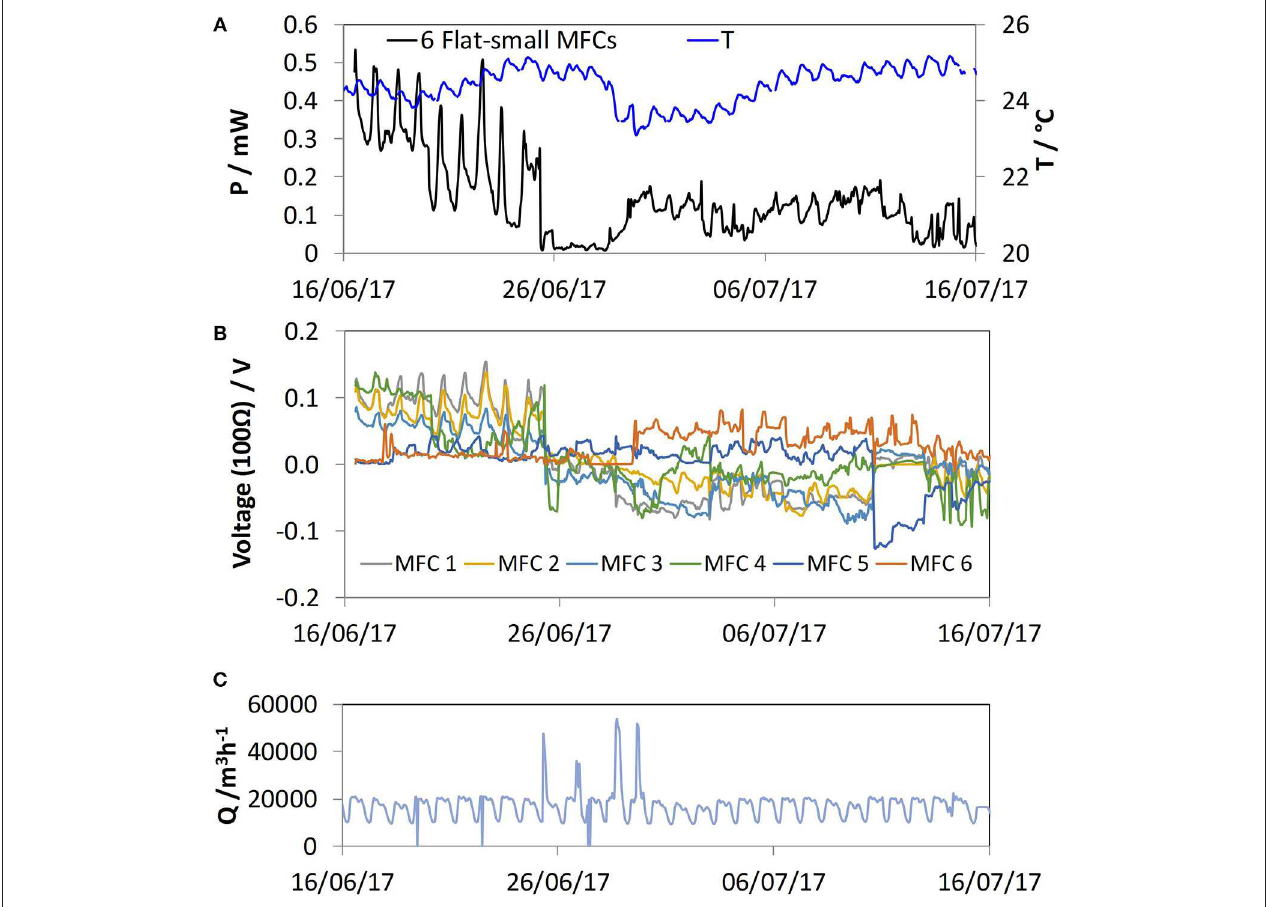
FIGURE 5 | Total power (A) and individual voltage trends (B) produced by six Flat-small MFCs (10 × 13cm) during 1 month operation (June–July 2017) at Milano-Nosedo WWTP. Wastewater temperature (A) and flow (C)